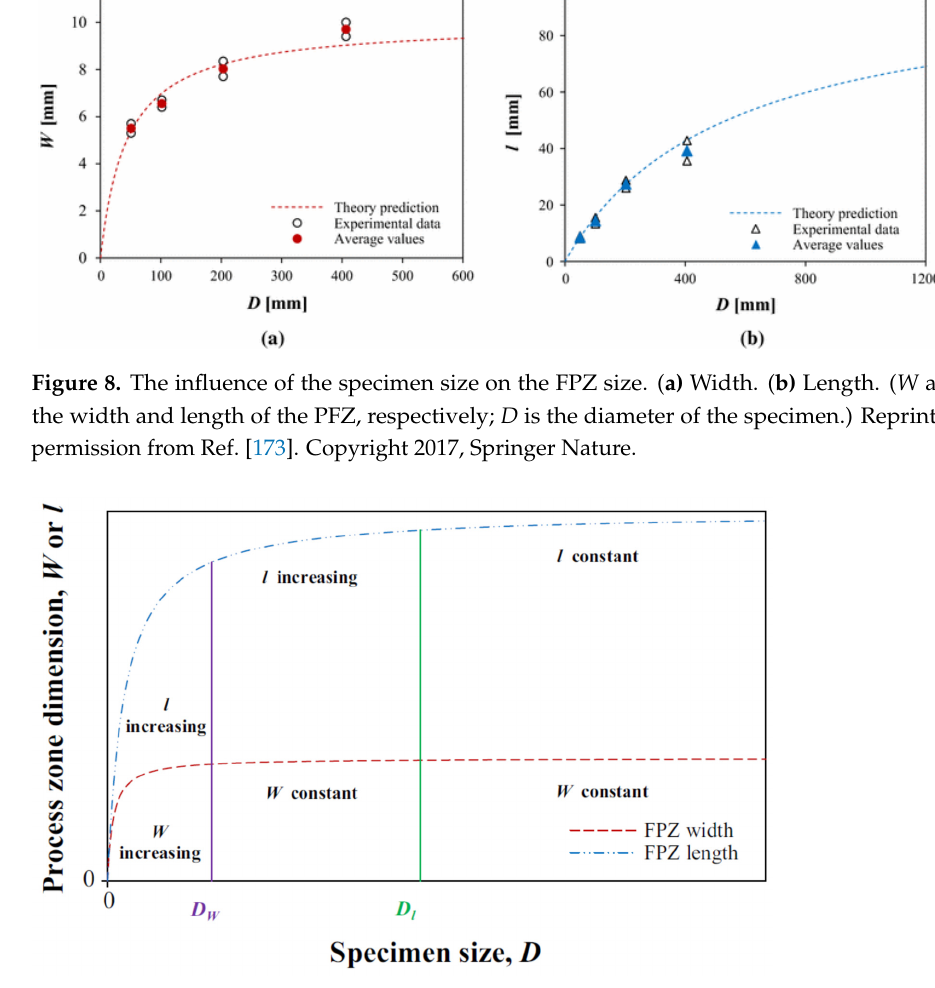
Figure 9. The concept map of the effect of specimen size on the dimensions of the FPZ. Reprinted with permission from Ref. [173]. Copyright 2017, Springer Nature.